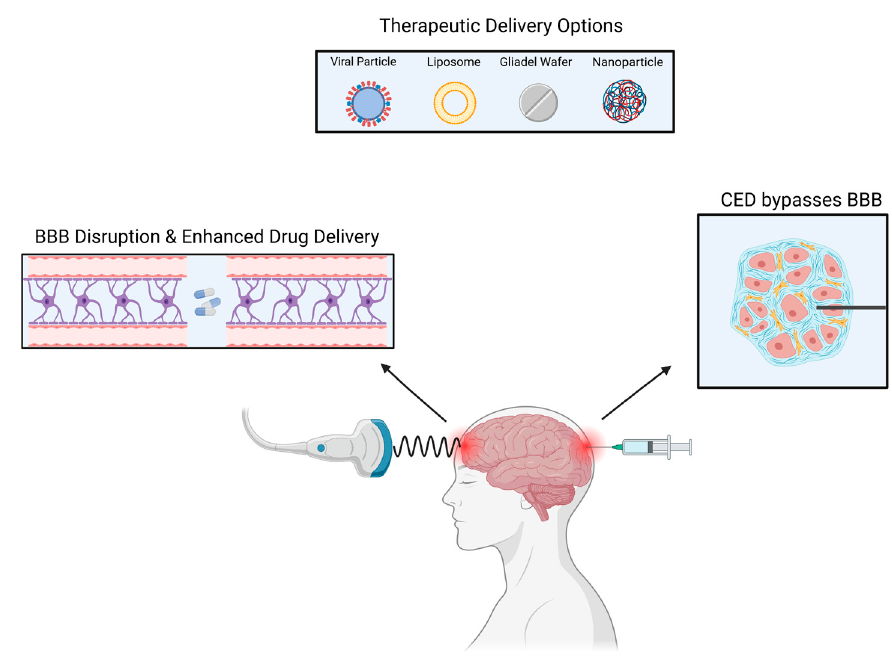
Figure 2. Several methods can be used to deliver drugs to intracranial